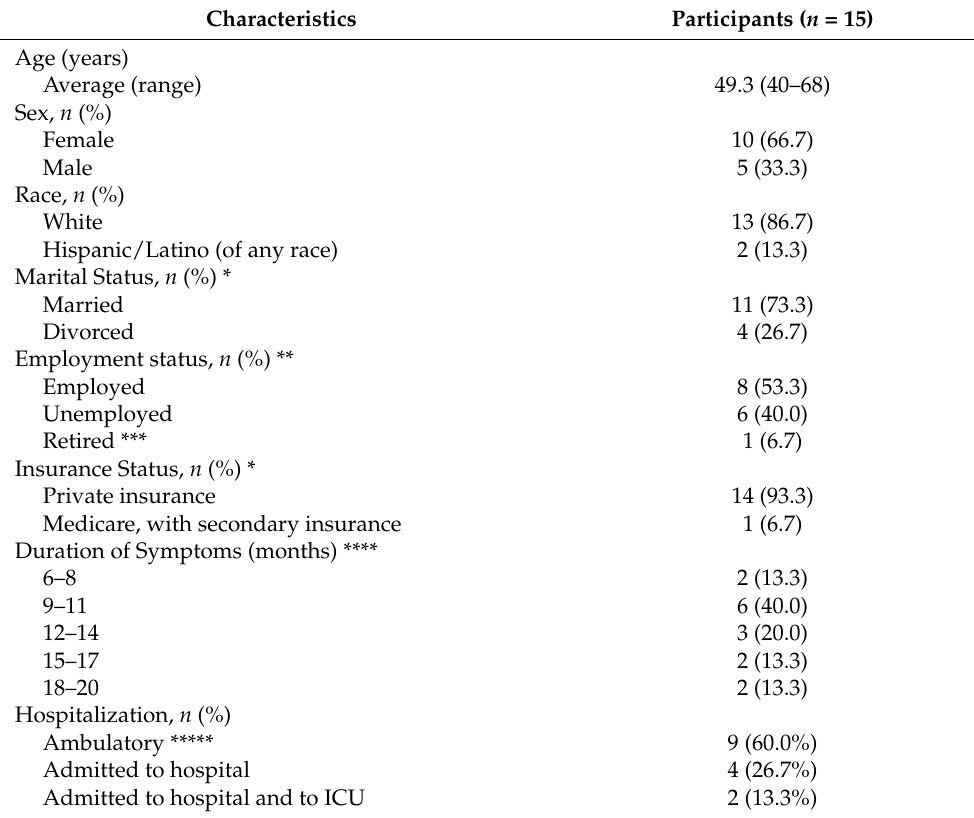
Table 1. Characteristics of interview